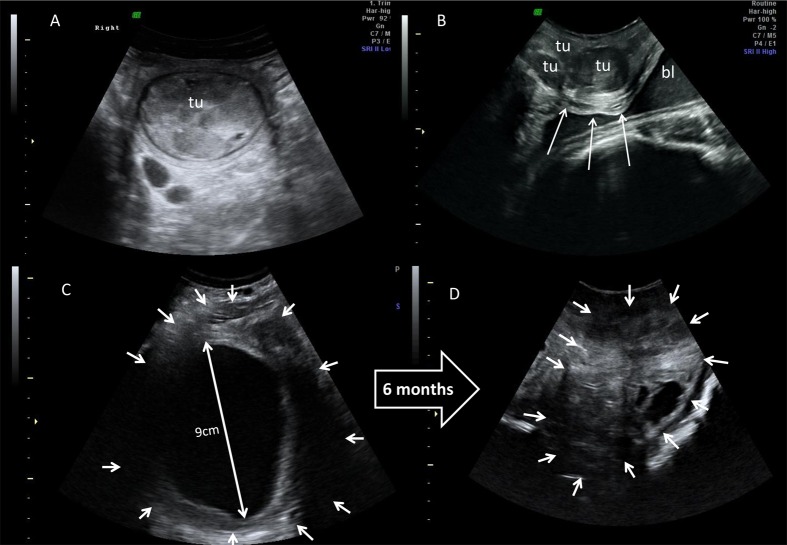
Ultrasonographic images.A: Solid uterine tumour (tu) in a white rhinoceros. B: multiple vaginal tumours (tu) in a Greater one-horned rhinoceros. The largest tumour compresses the ureter (↓) above the bladder (bl). C + D: Ovary of a Greater one-horned rhinoceros before and 6 months after GnRF vaccination. Dimensions of the ovary (←) and follicular activity regressed notably after the vaccination. Note large physiological diameter of the dominant follicle and small and irregular shaped atretic follicles before and after vaccination. Standard scales of 1 cm are imprinted on the side of the ultrasound images.